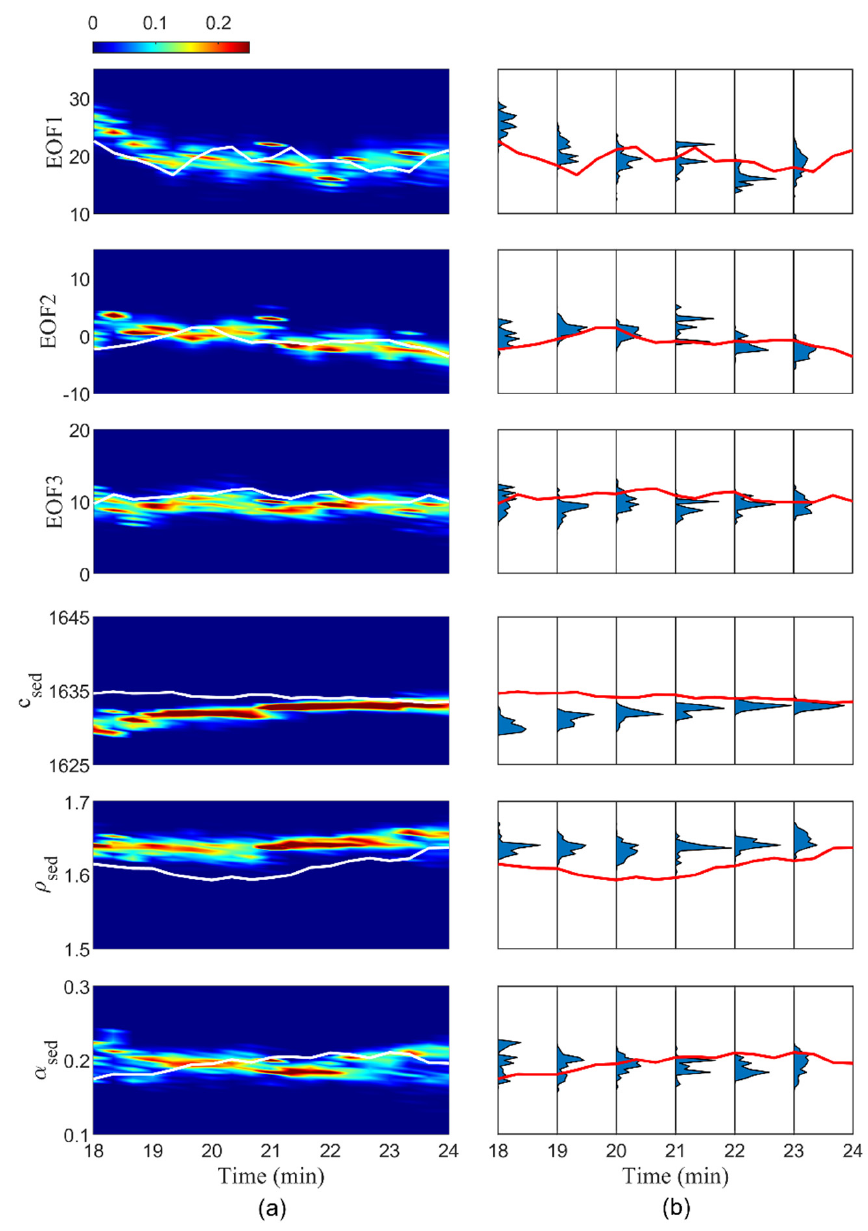
Figure 6. Improved PF results: ( a ) variation in marginal PPDs for three EOFs and sediment parameters from 18 to 24 min, ( b ) vertical slices of the PPDs are given at every 1 min interval. Solid lines represent the true values.